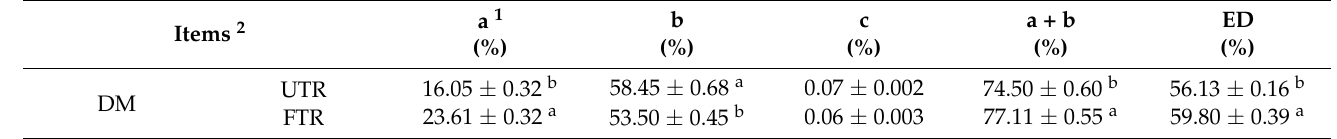
Table 5. The rumen degradation parameters of components in tea residue